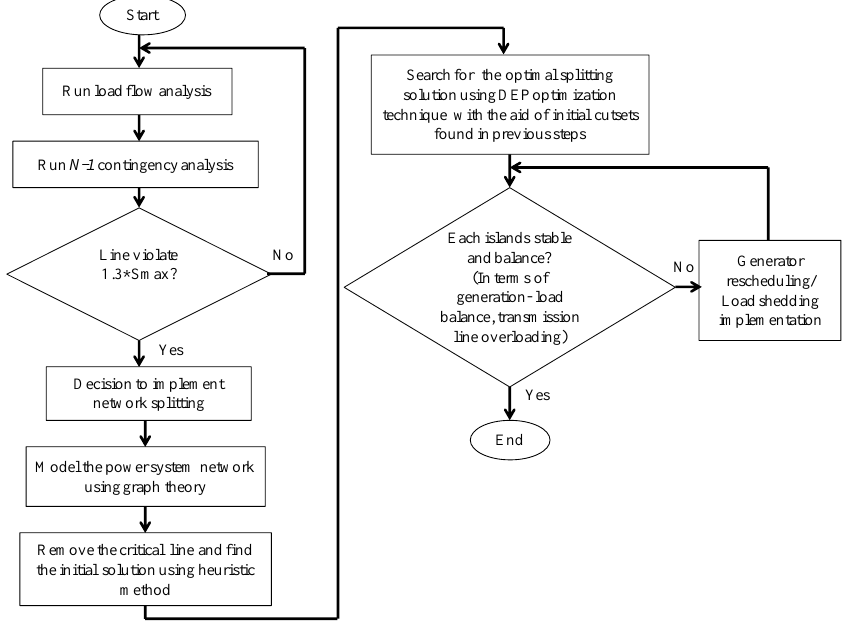
Figure 1. The flowchart of the proposed approach.